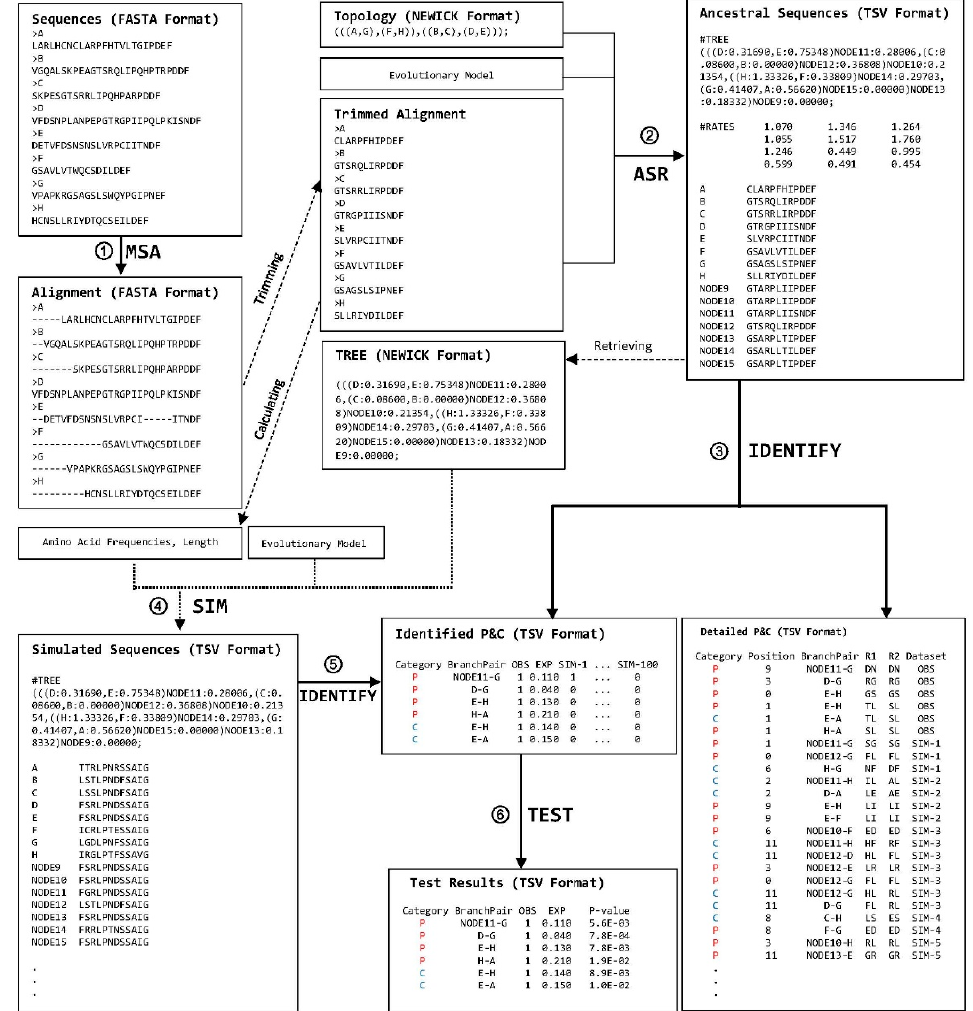
Figure 1. Overview of the ProtParCon analytical scheme. During the multiple sequence alignment (MSA) stage, protein sequences are aligned while gaps and ambiguous character states are trimmed. In the ancestral state reconstruction (ASR) stage, ancestral character states at each site are inferred for each internal node in the reconstructed tree. Observed parallel and convergent amino acid replacements and convergent replacements by C (blue). Simulations are conducted in the SIM (simulation) stage. Simulated sequences are evolved according to the following parameters: (1) an evolutionary model (a replacement rate matrix), (2) the branching pattern and branch lengths of the tree estimated in the ASR stage, and (3) amino acid frequencies and sequence length estimated from the trimmed